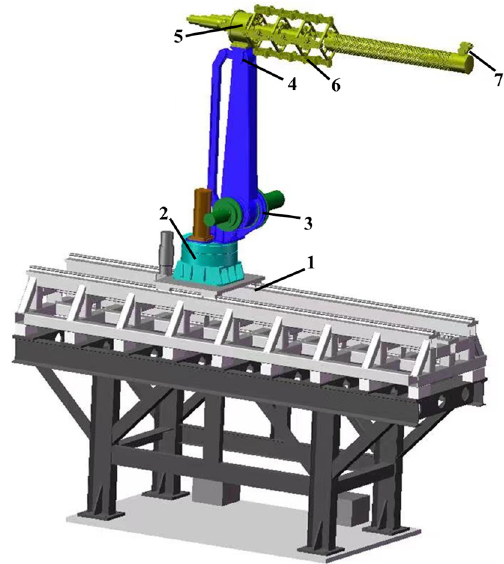
Figure 1. 3D model of the robot. For the convenience of description, the seven joints are numbered from 1 to 7, from the base to the terminal of the robot. from 1 to 7, from the base to the terminal of the